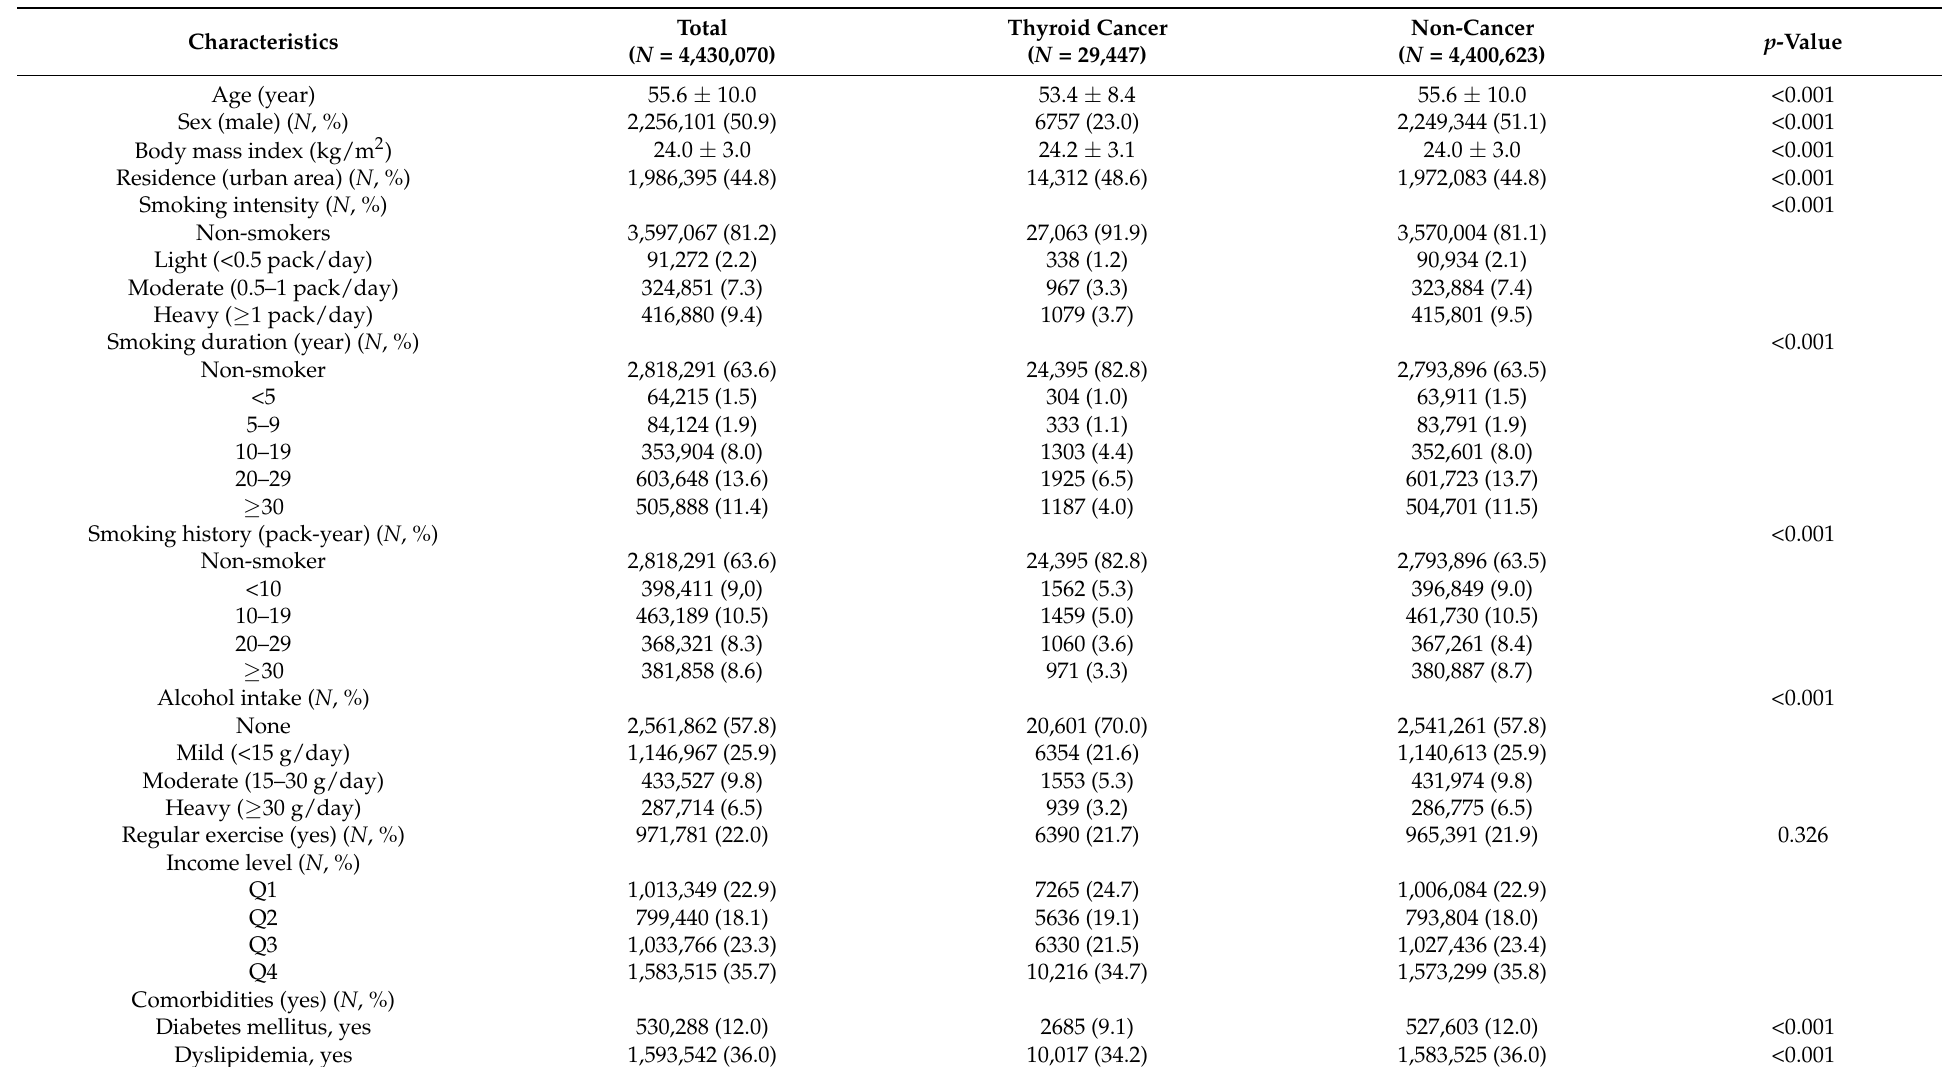
Table 1. Baseline characteristics of thyroid cancer and non-thyroid cancer